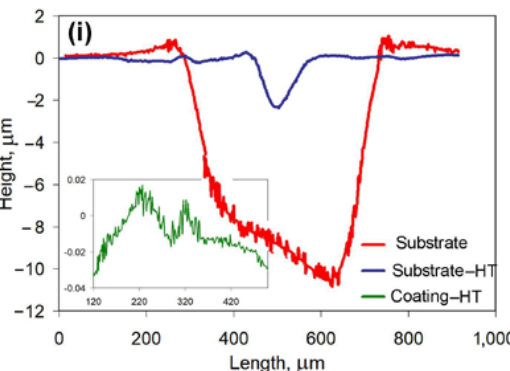
Figure 8. Dry-sliding worn surface characterization. Three-dimensional (3D) images of wear tracks on ( a , c , e ) the substrate- HT and on ( b , d ) the heat-treated coating after testing against ( a , b ) the 100Cr6 steel ball, ( c , d ) the SiC ball, and ( e ) the diamond cone. ( f ) Different fragments of a “diamond cone” wear track on the heat-treated coating (depth scale bar is given in micrometers). Wear track profiles for testing against ( g ) the 100Cr6 steel ball, ( h ) SiC ball, and ( i ) the diamond cone.